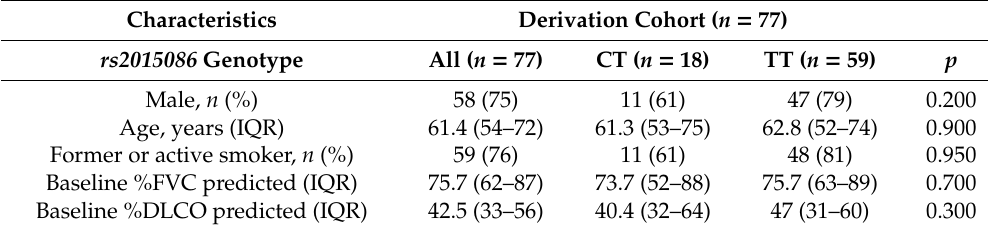
Table 1. Baseline characteristics in IPF patients divided by CCL18 rs2015086 genotype in the derivation